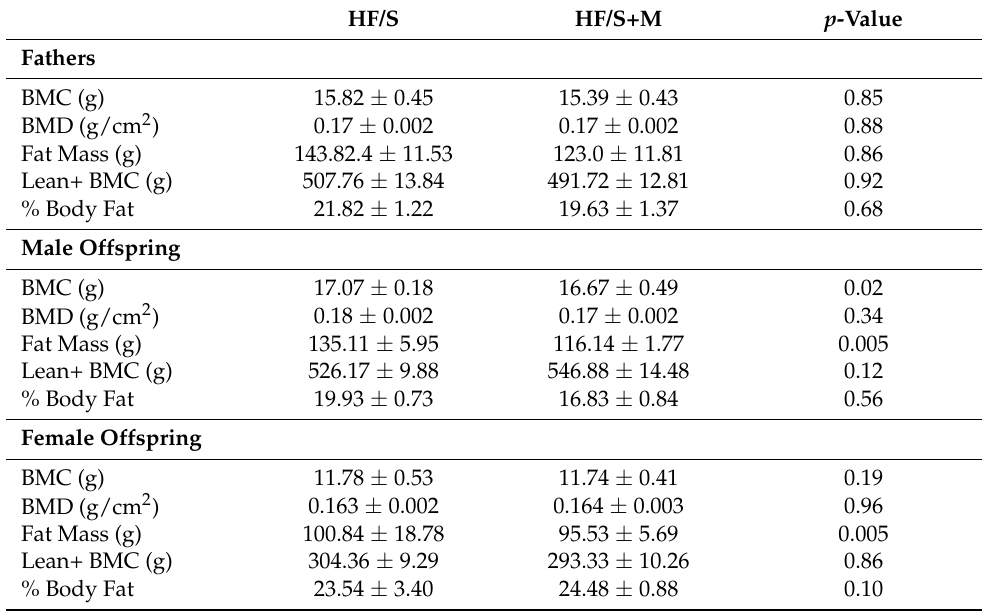
Table 1. The body composition of fathers at mating at 12 weeks of age and offspring at 16 weeks of